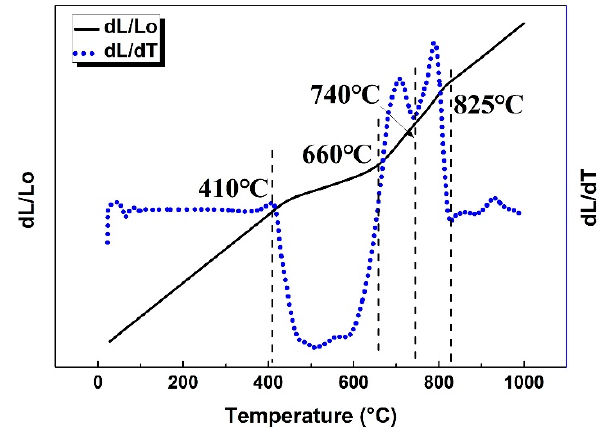
Figure 2. Dilatometric curve (in solid) and the derivative curve (dotted curve) at 1 °C/min during the continuous heating process.